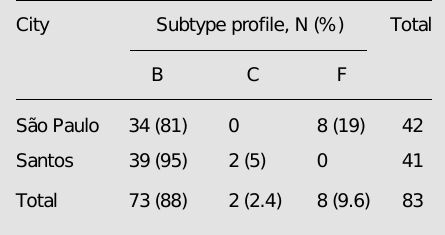
Table 1 - Distribution of HIV-1 subtypes in São Paulo and Santos (Brazil). Subtype was determined by heteroduplex mobil- ity analysis. The prevalence of subtype F was higher in São Paulo than in Santos (P = 0.002, chi- square